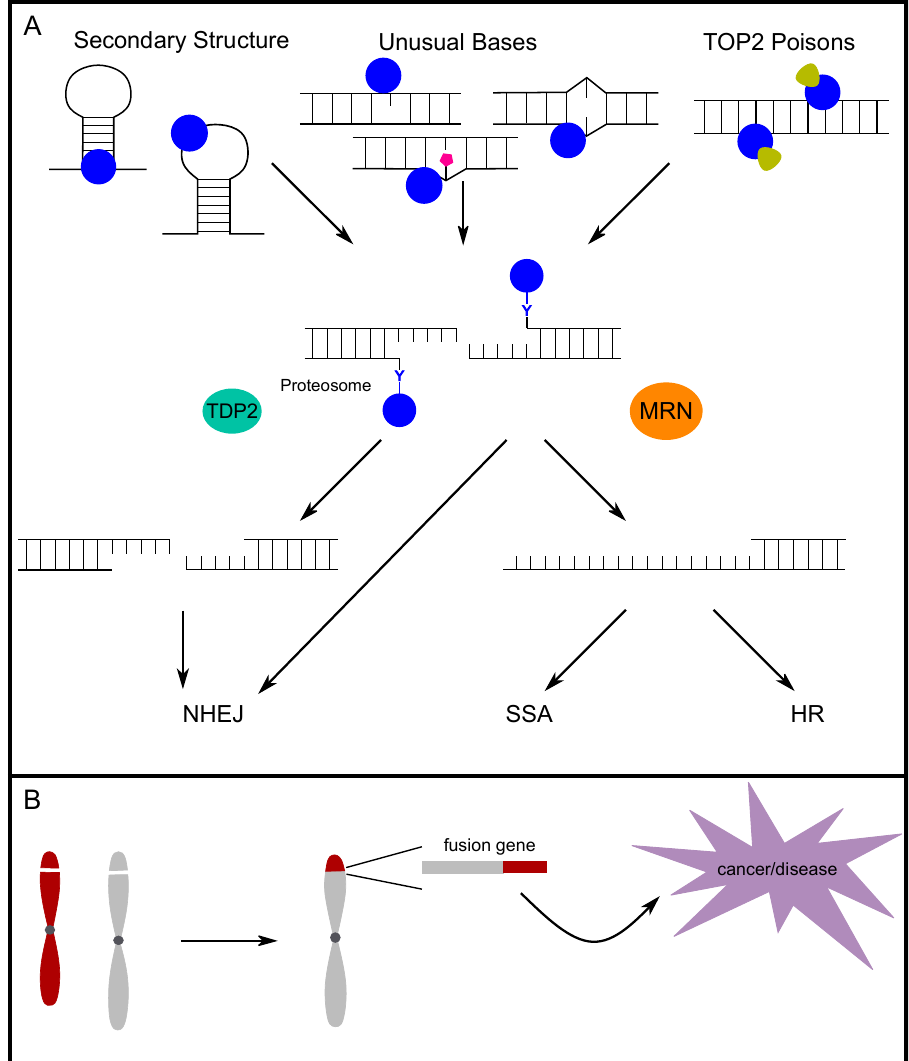
Figure 2. Targets and stabilizers of TOP2 cleavage, repair pathways, and consequences of improper repair. ( A ) Alternative DNA secondary structures, such as hairpins, can be targets of TOP2 (blue) cleavage both at single-stranded loops and bases of stems. Mismatched bases, abasic sites and sites with bulky adducted bases, also serve as TOP2 targets and act as endogenous TOP2 poisons stabilizing TOP2ccs. Furthermore, many exogenous TOP2 poisons are capable of stabilizing cleavage complexes. Persistent TOP2ccs are removed either through a TDP2-dependent pathway or through an MRE11 (MRE11 / RAD50 / NBS1; MRN) pathway. TDP2 works following proteosomal degradation of TOP2 and removes the final tyrosine-bound nucleotide. The non-homologous end-joining (NHEJ) pathway repairs the TDP2-modified ends. When MRE11 (MRN) is employed in repair of TOP2ccs, end resection occurs and triggers repair pathways, non-homologous end-joining (NHEJ), single-strand annealing (SSA), or homologous recombination (HR), dependent on what proteins are further recruited and the extent of end resection. ( B ) Consequences of unrepaired or illegitimately repaired DSBs on human chromosomes can lead to gene fusion and rearrangement events which underlie cancers and other